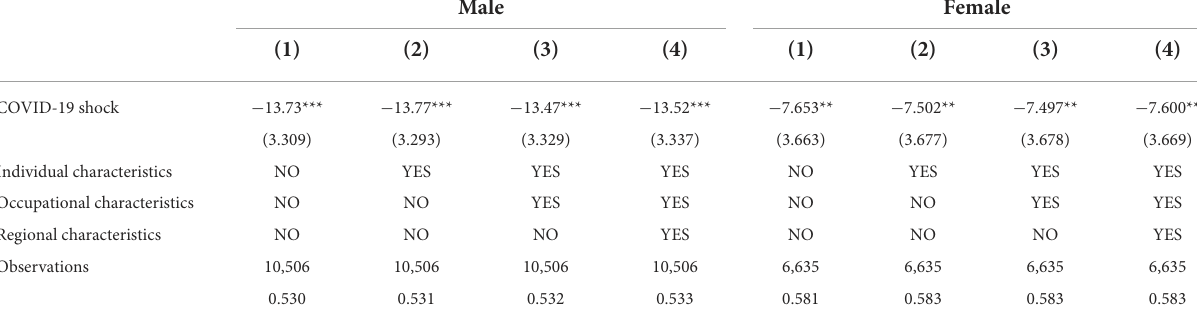
TABLE 4 Effect of COVID-19 on income (by gender).